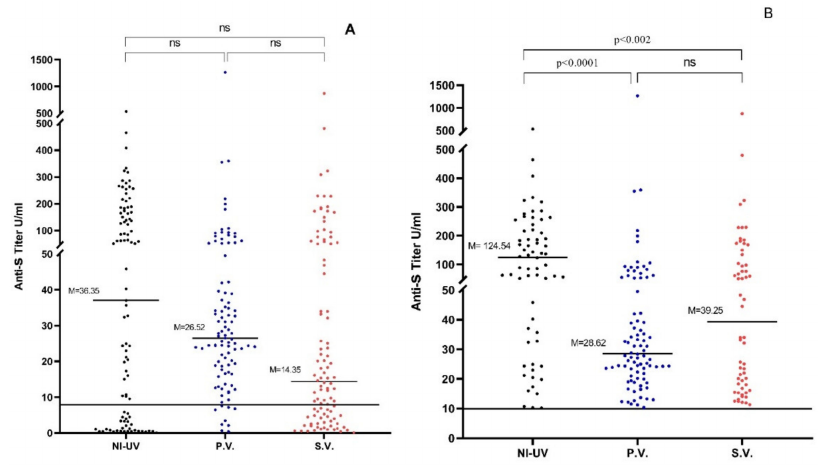
Figure 1. ( A ) Anti-S IgG titers in the 3 studied groups for all participants. ( B ) Anti-S IgG titers in the 3 studied groups for all participants after excluding the seronegative samples. NI-UV: Nat- urally Infected Unvaccinated, P.V.: Pfizer-Vaccinated, S.V.: Sinopharm-Vaccinated, M: Median, ns: Nonsignificant ( p > 0.05).